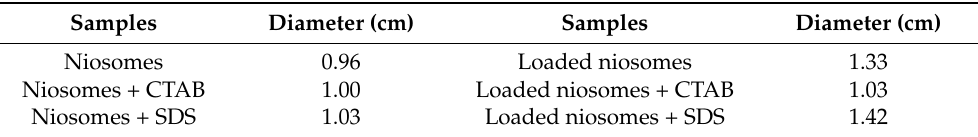
Figure 5. ( A ) Niosomes loaded with vanillin, ( B ) Niosomes with CTAB loaded with vanillin, ( C ) Niosomes with SDS loaded with vanillin, ( D ) Niosomes without vanillin, ( E ) Niosomes with CTAB without vanillin, ( F ) Niosomes with SDS without vanillin.